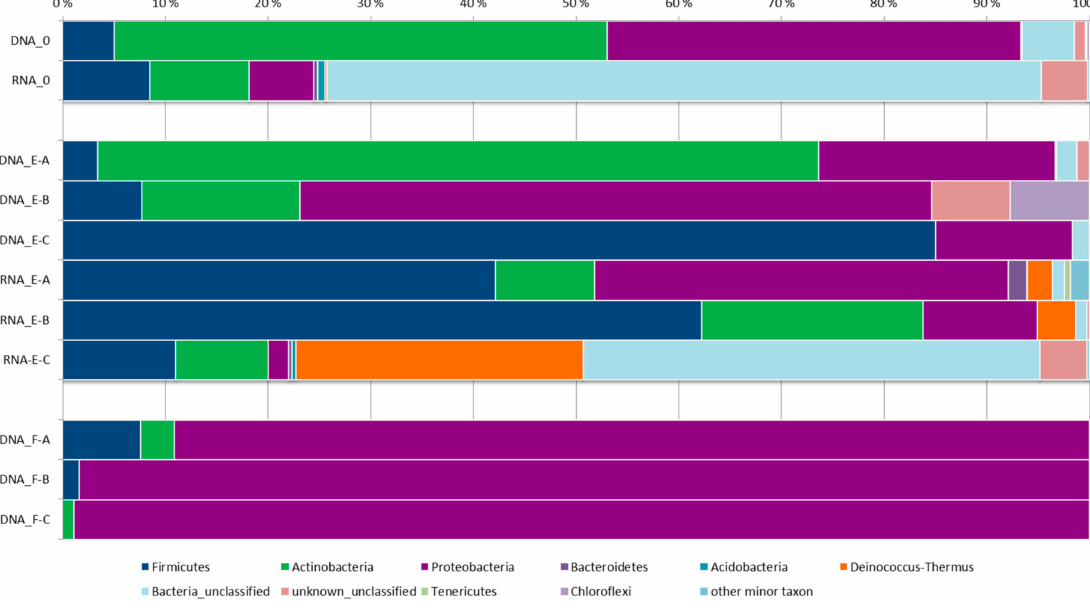
Figure 4. Taxonomy of bacterial 16S rRNA gene OTU sequences at phylum level. First are the samples representing the original fracture fluid: DNA_0 and RNA_0 followed by the enriched samples representing the communities in the incubated microcosms: DNA_E—samples A, B, C (DNA) and RNA_E—samples A, B, C (RNA). At the bottom are the labelled DNA_F—samples A, B, C (DNA-SIP). The used cut-off value for this illustration was ≥ 6